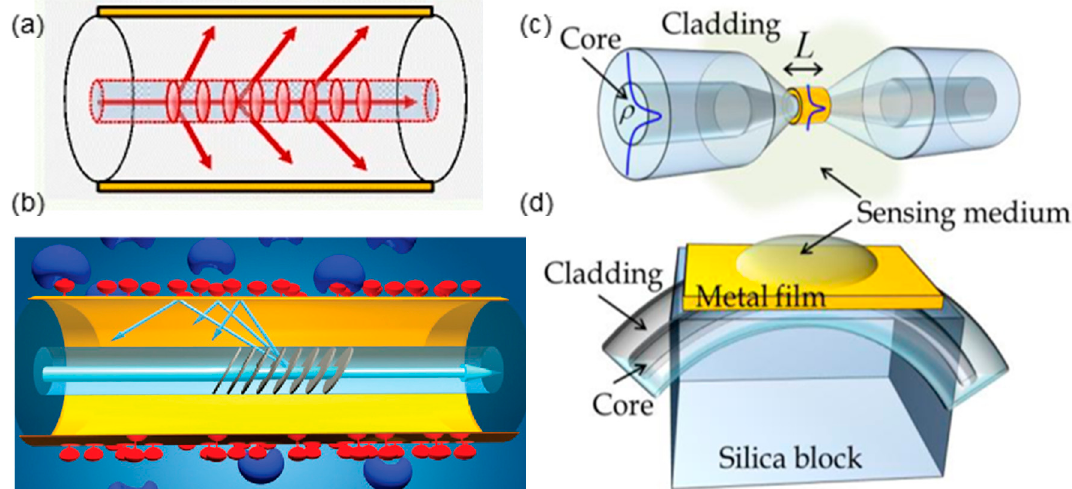
Figure 2. Fiber-optic surface plasmon resonance (SPR) sensor based on ( a ) long-period fiber grating (LPG) (Figure adapted with permission from reference [12]). ( b ) tilted fiber Bragg grating (TFBG) (Figure adapted with permission from reference [15]). ( c ) tapered fiber. ( d ) side-polished fiber (Figure ( c ) and ( d ) adapted with permission from reference [18]).